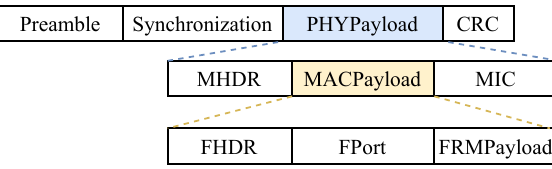
Figure 2. LoRaWAN message